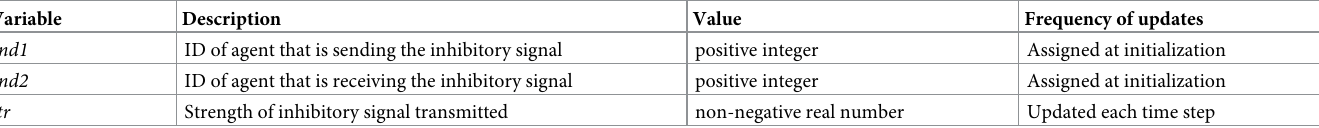
Table 2. Overview of variables assigned to each connection between